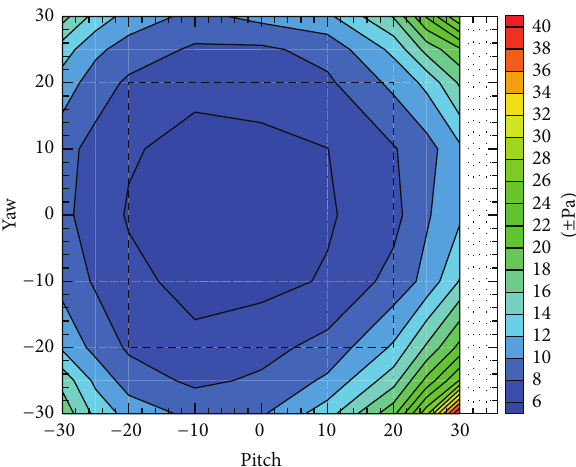
Figure 13: Velocity uncertainty at 20 m/s, 81 (9 × 9) points (in terms of ± m/s).